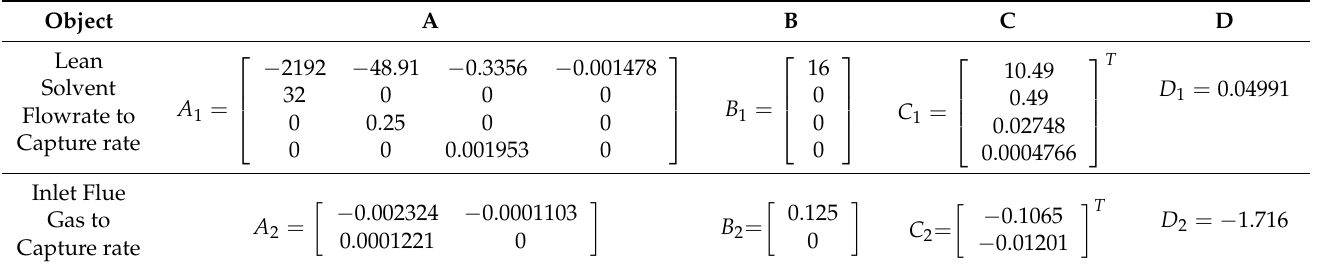
Table 3. Identification model of the post-combustion CO 2 capture